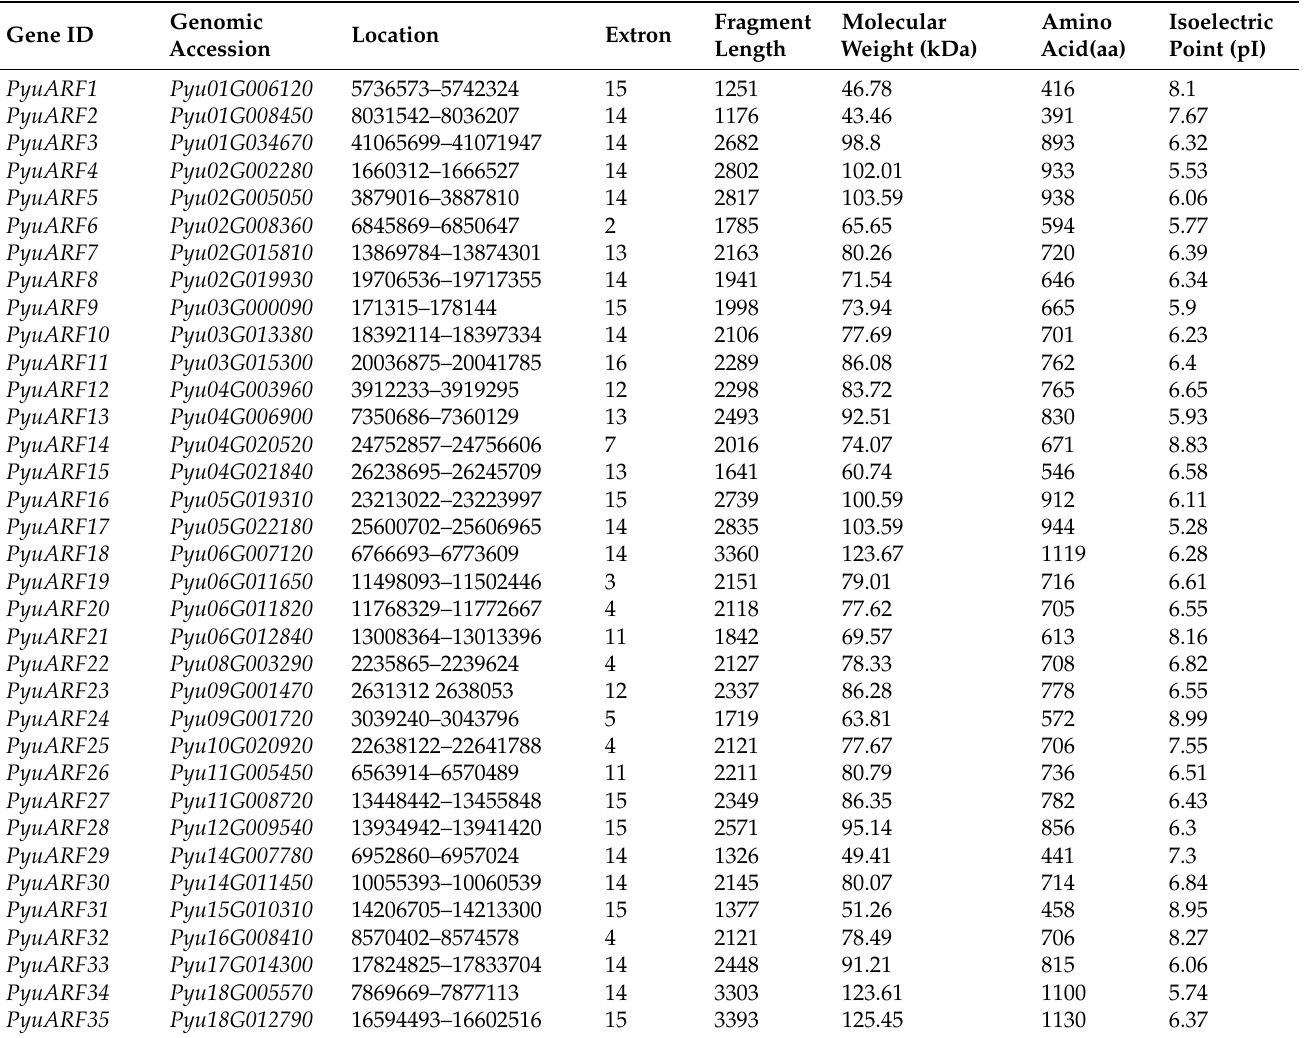
Table 1. Characteristics of the identified PyuARF s family members in P. yunnanensis